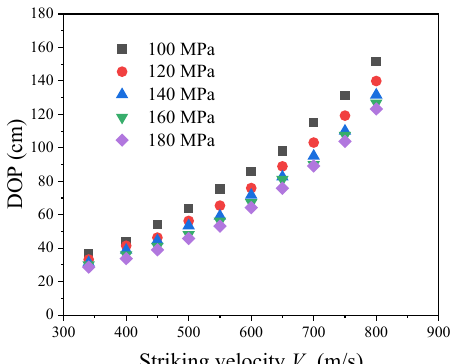
Figure 17. Velocity and displacement histories of projectiles at striking velocities of 410 m/s and 664 m/s.